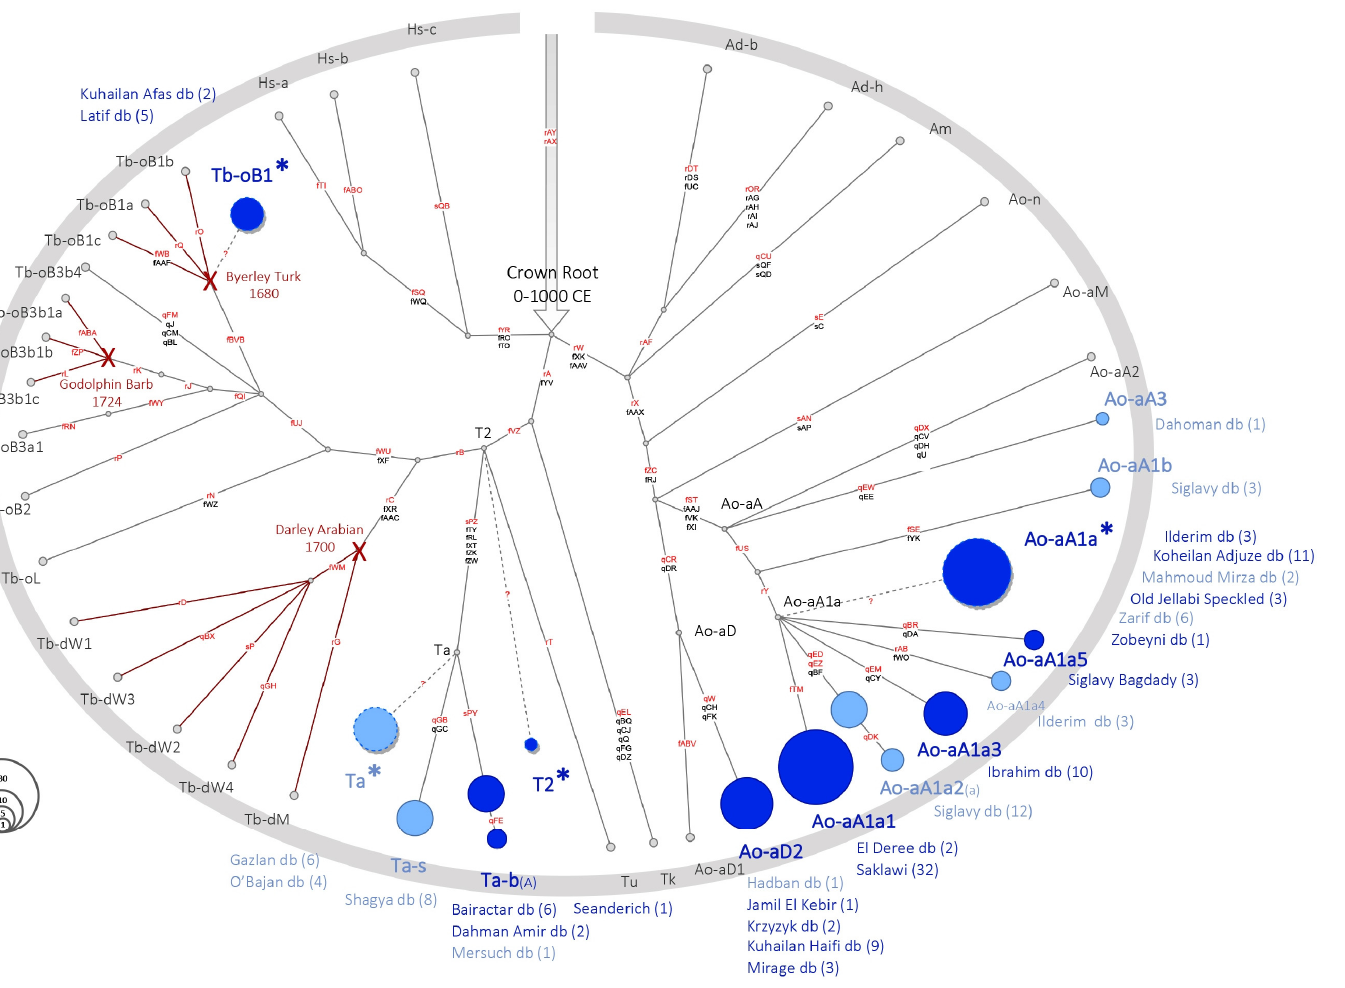
Figure 2. MSY HTs in Arabian sire lines. Simplified crown HT network based on 118 variants. Genotyping results from 145 males are shown in blue circles with size proportional to frequency. Details on samples are given in Table 1, and Table S5 (samples are indicated in Column J; Foundation sires shown in Column AI). Foundation sires are shown for each HT, with the number of samples for each line in parenthesis. HTs/foundation sires that are only active in breeds other than Arabians are given in light blue. Genealogies of the English Thoroughbred founders are outlined with red crosses and the thoroughbred specific subhaplogroups with the branches in